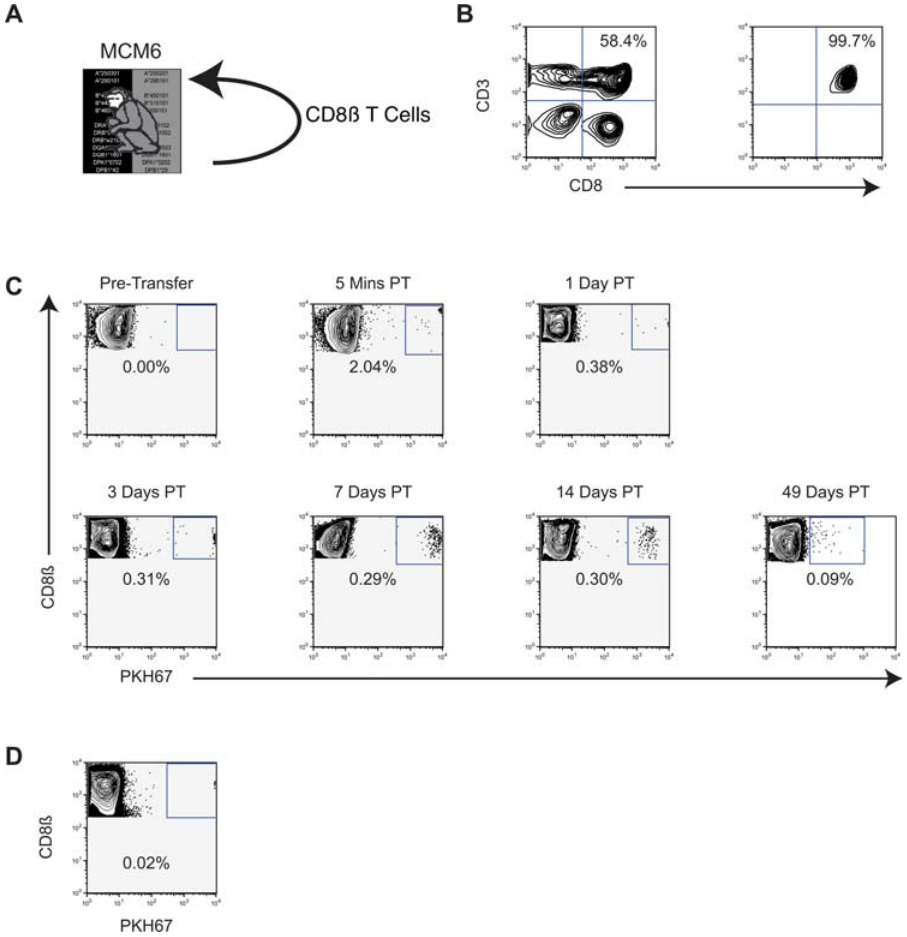
Figure 2. Autologous adoptive transfer . A Diagram displaying the transfer protocol. B Selection for CD8ß + cells. The left panel is unmanipulated PBMC. The right panel is the positive fraction collected following CD8ß enrichment gated on lymphocytes. C Transfused cell persistence after transfer. Percentages are of total CD8ß + cells in the PBMC of the animal based on the lymphocyte gate. D PKH67 + cells in lymph node of animal MCM6. The right inguinal lymph node was processed three days post-transfer to measure persistence of PKH67 + cells. The percentage of PKH67 + cells is based on total CD8ß + cells in the lymph node lymphocyte gate.